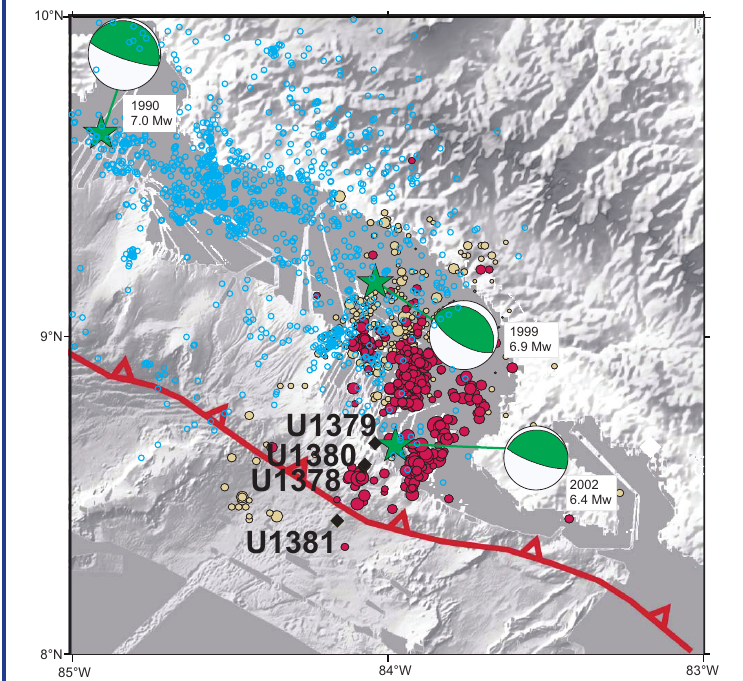
Figure 3. Seismicity along the Costa Rica margin. Open blue circles show seismicity recorded by the Costa Rican National Seismological Network (RSN) in the period 1992–2007. Focal mechanisms correspond to large earthquakes (Mw > 6.4) nucleated in the seismogenic zone over the past 25 years. Red circles show aftershocks from the 2002 Osa event, and beige circles show aftershocks from the 1999 Quepos event. Red line marks the trench; triangles are drawn toward the overriding plate. Modified from Arroyo et al.